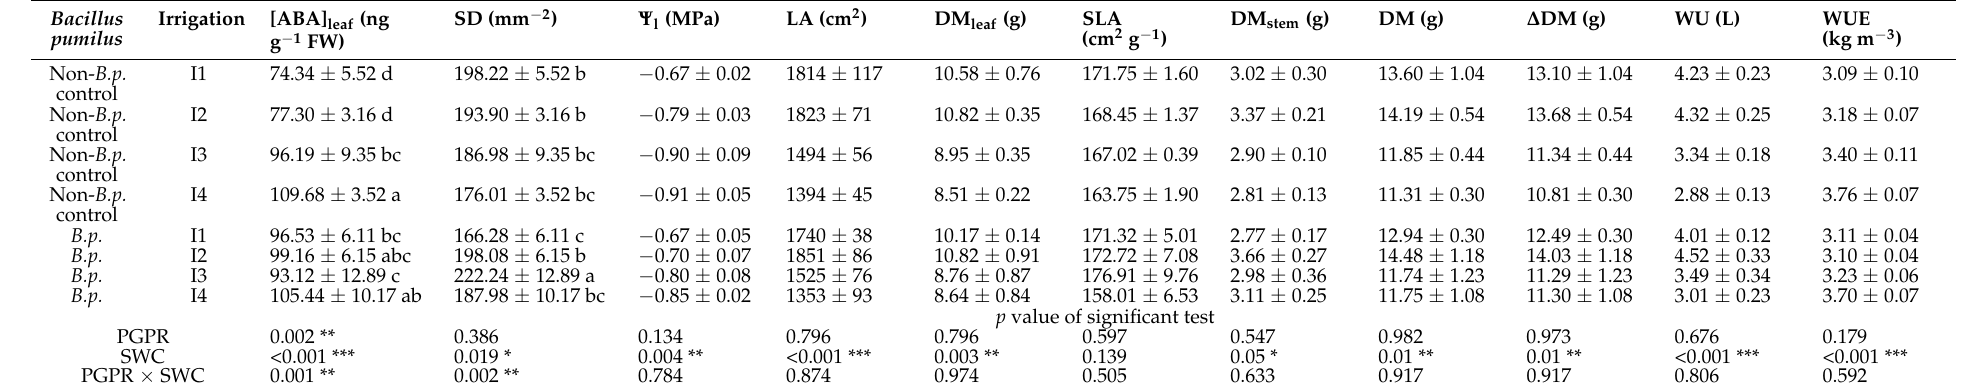
Table 2. The effect of Bacillus pumilus ( B.p. ) inoculation on leaf ABA ([ABA] leaf ), stomata density (SD), leaf water potential ( Ψ l) , leaf area (LA), leaf dry matter (DM leaf ), specific leaf area (SLA), dry matter (DM), dry matter increment ( ∆ DM), plant water use (WU) and water use efficiency (WUE) under four irrigation